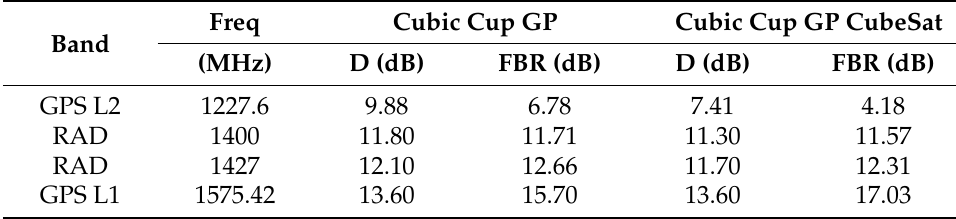
Table 7. Simulation results for cubic cup CubeSat sized ground plane.